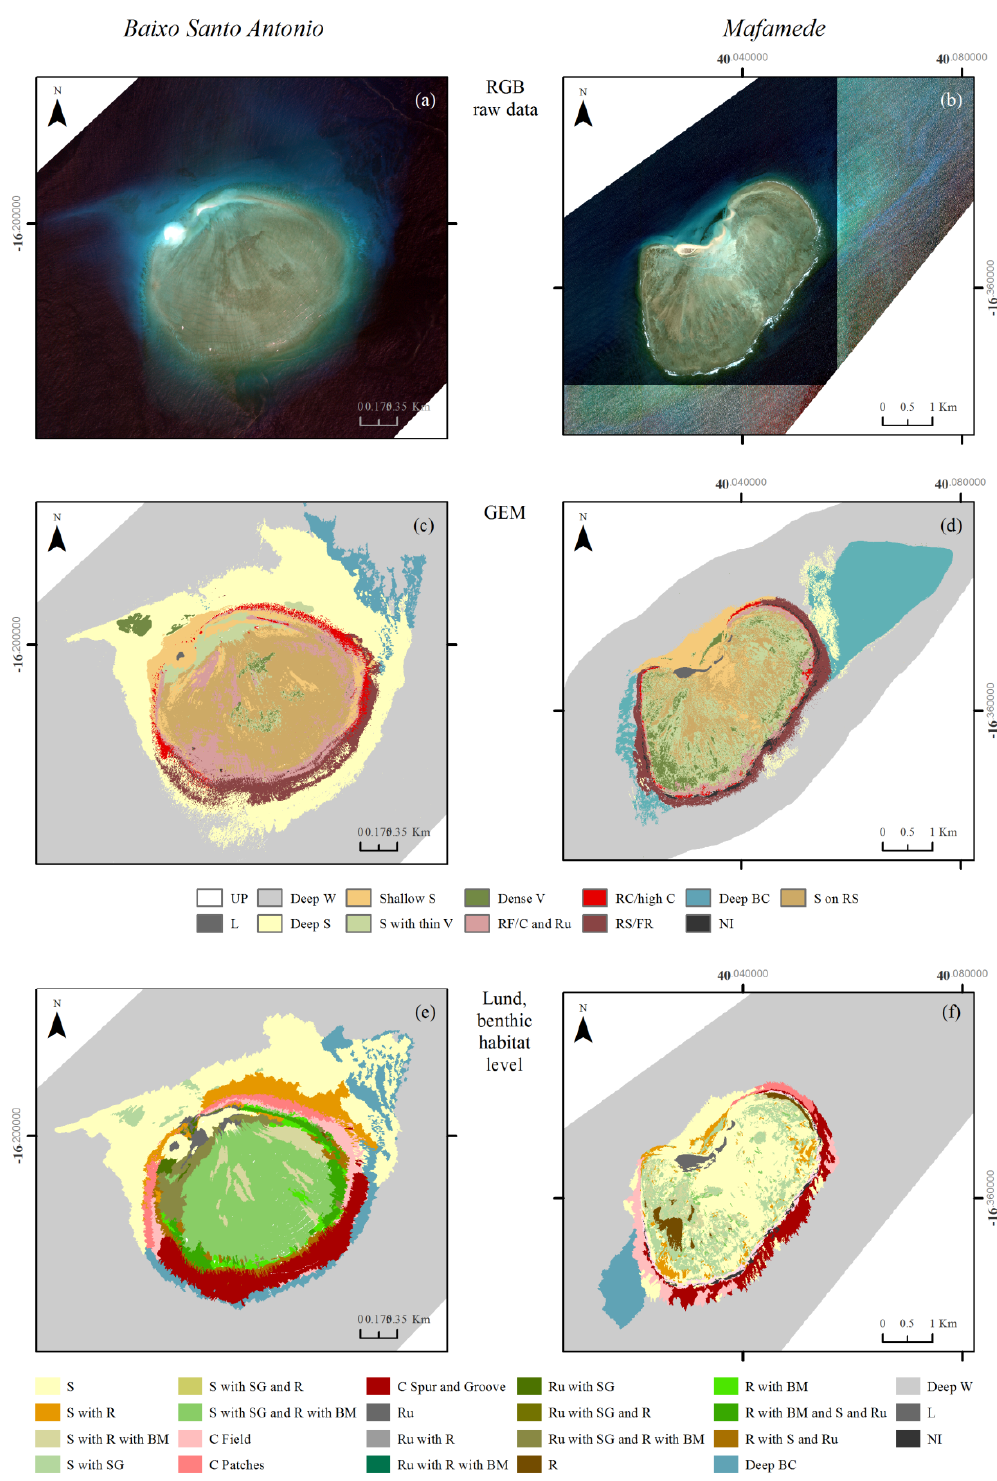
Figure 2. Example of ( a , b ) raw data (min and max percentage clip = 0.2); ( c , d ) GEM and ( e , f ) Lund mapping results for Baixo Santo Antonio and Mafamede; BC=benthic cover, BM = brown macroalgae, C = coral, FR = fore reef, L = land, NI = No information, R=rock(s), RC = reef crest, RF = reef front, RS = reef slope, Ru = rubble, S = sand, SG = seagrass, UP=unprocessed,V = vegetation, W = water.